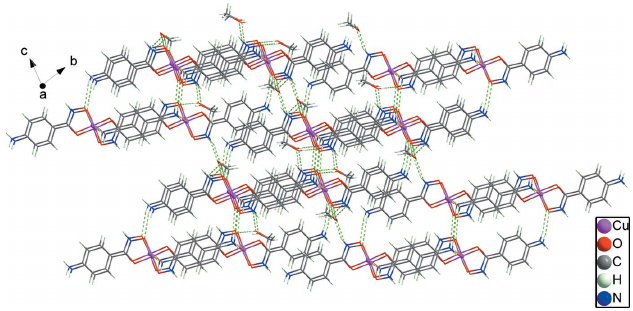
Figure 2 Crystal packing of title complex, viewed down the a axis, with hydrogen bonds drawn as dashed lines.